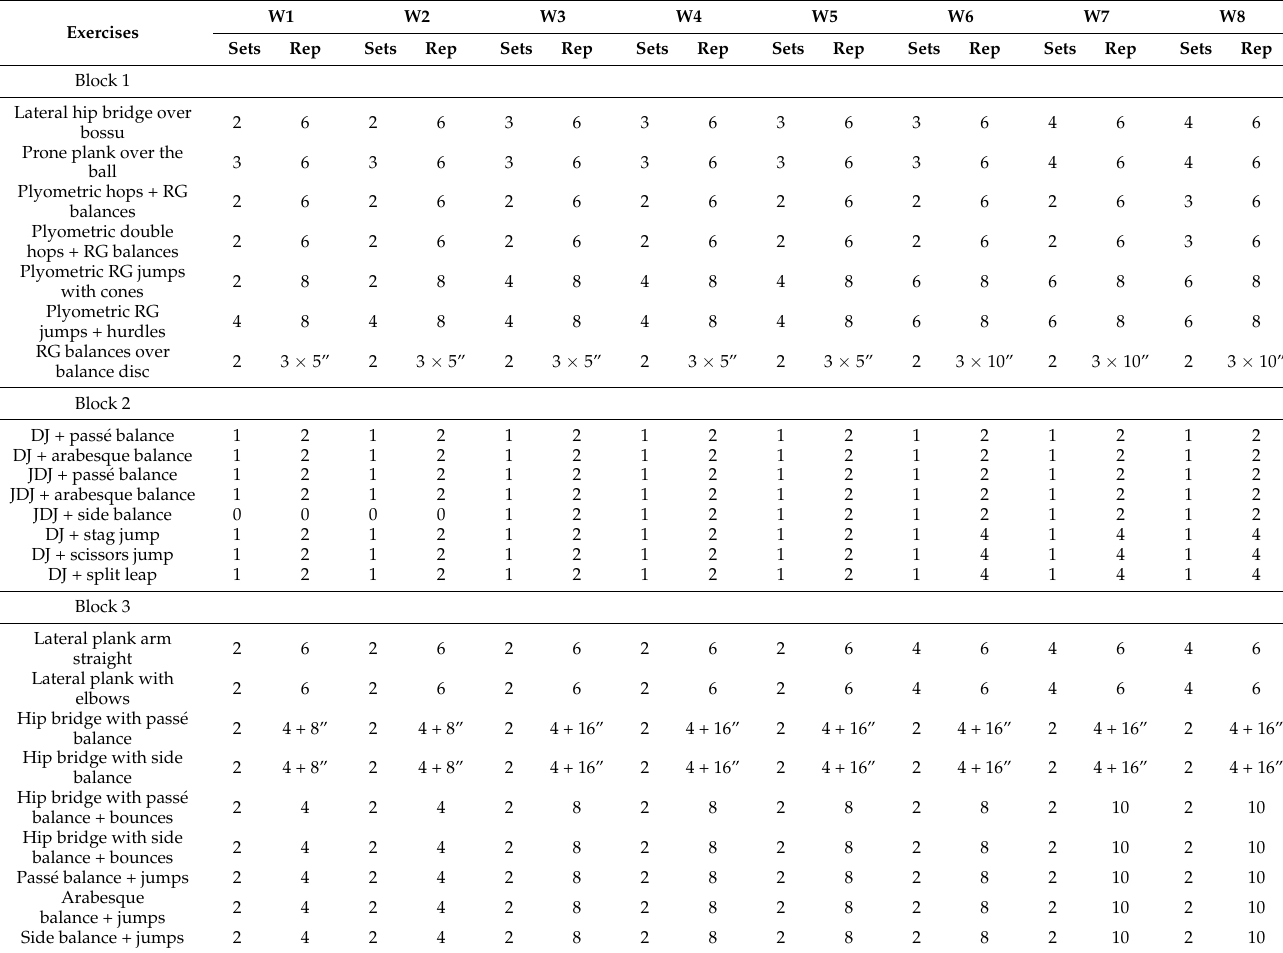
Table 2. Overview of the 8 week integrated functional CPT